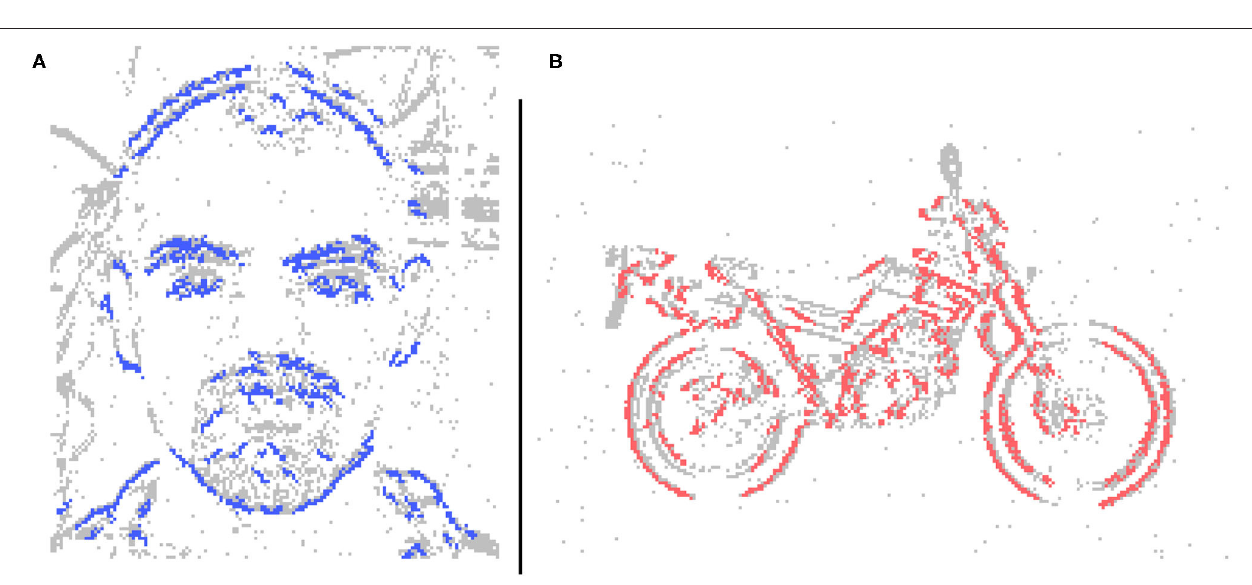
FIGURE 5 | Segmentation overlays for the (A) Face and (B) Motorbike class from the N-CalTech